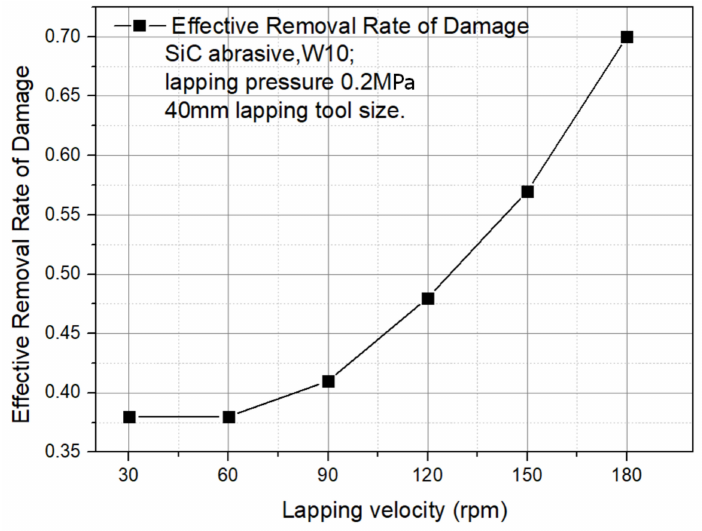
Figure 6. ERRD for di ff erent lapping